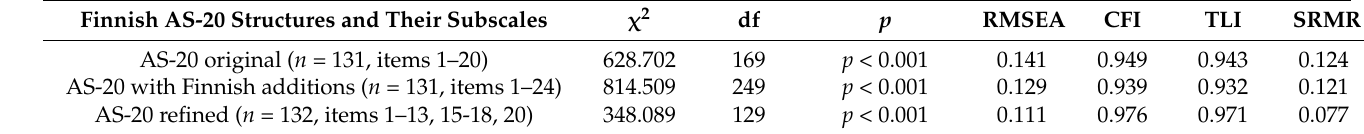
Table 4. The model fit indicators for the three structures of the Finnish